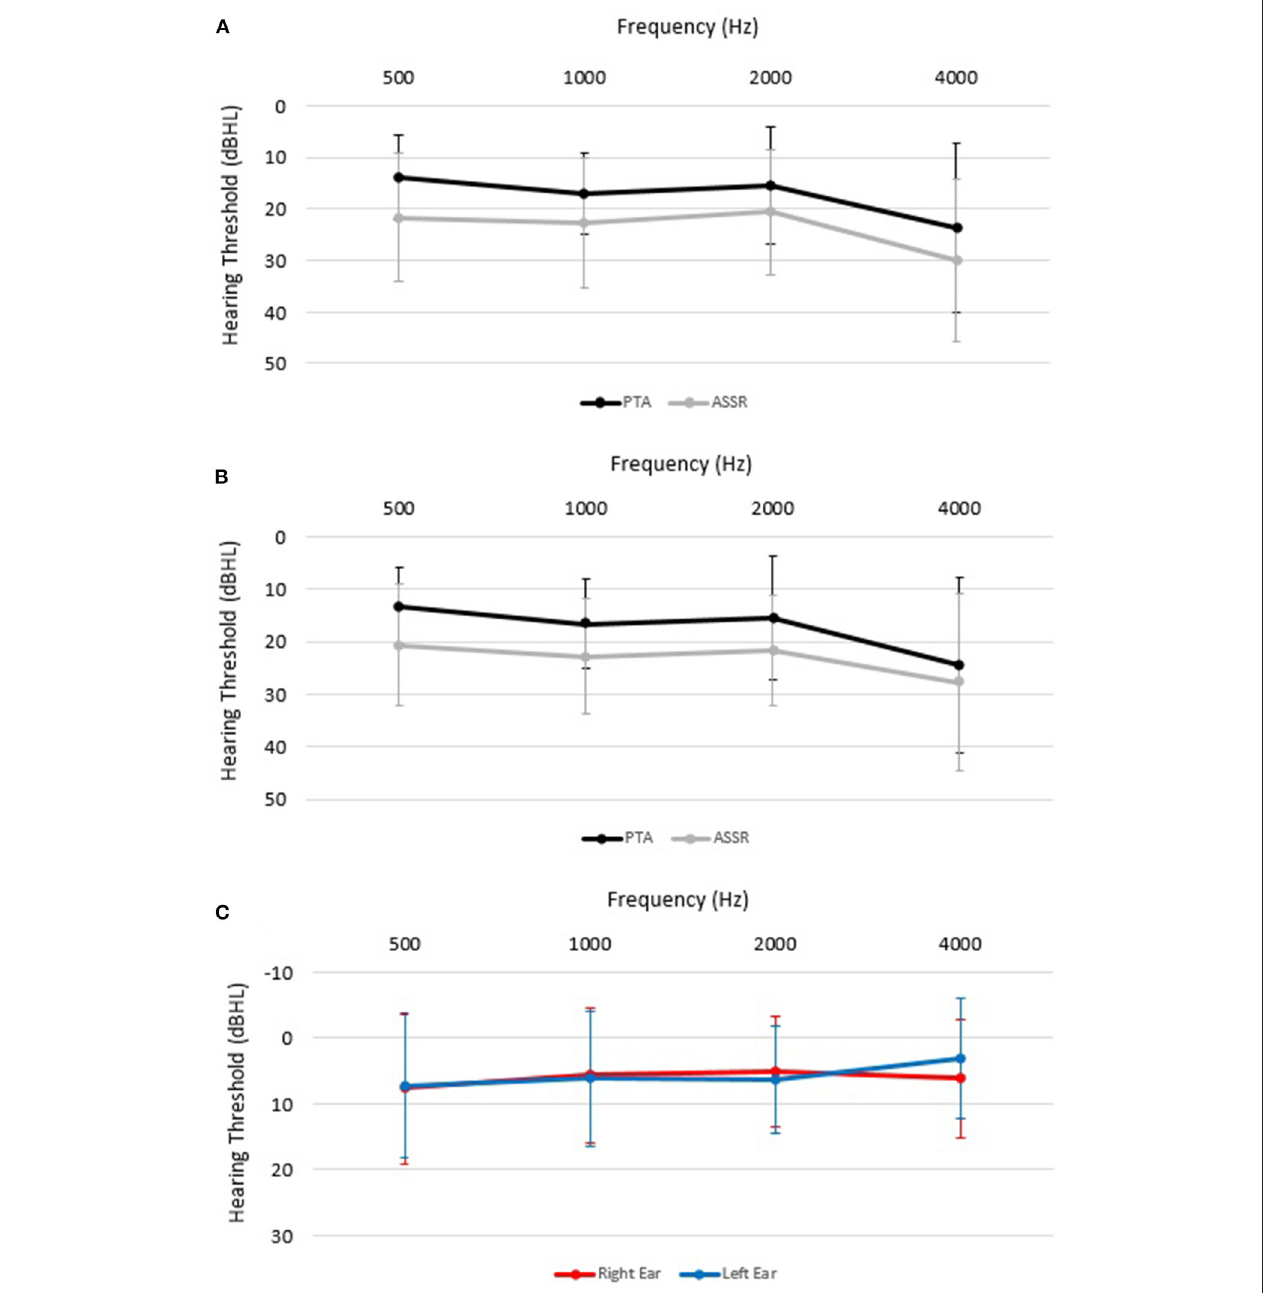
FIGURE 1 | Mean ( ± SD) pure tone audiometry (PTA; black lines A, B ) and auditory steady-state response (ASSR; gray lines A, B ) hearing thresholds (in decibels dBHL) for each carrier frequency in the right ear (A) , left ear (B) . (C) shows threshold differences between PTA and ASSR in left and right ears.